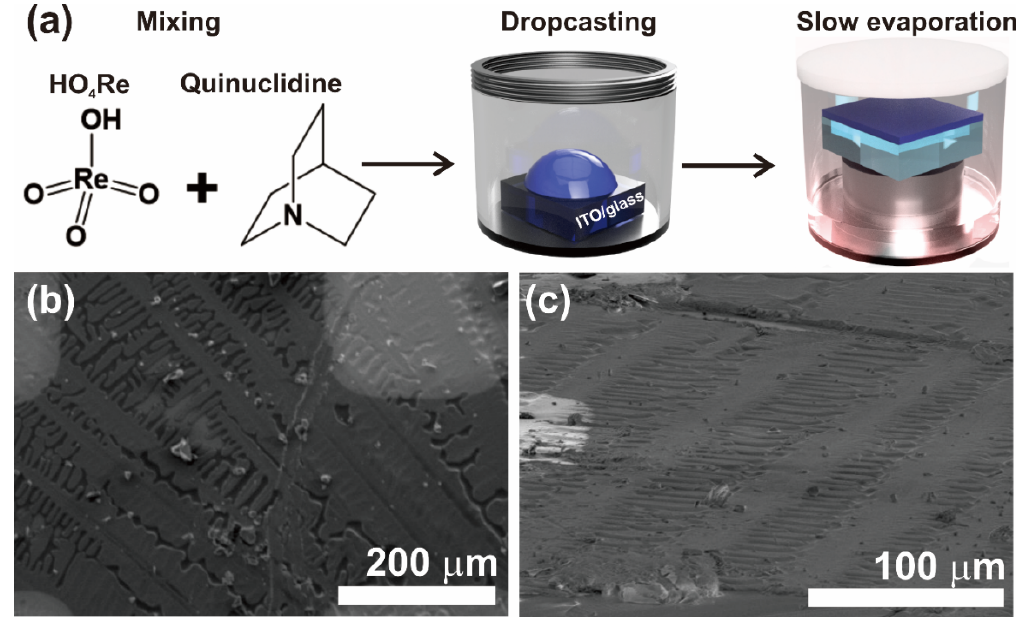
Figure 1. ( a ) A schematic showing the experimental procedure, with ( b ) top-view and ( c ) tilted-view SEM images of QP-80 .